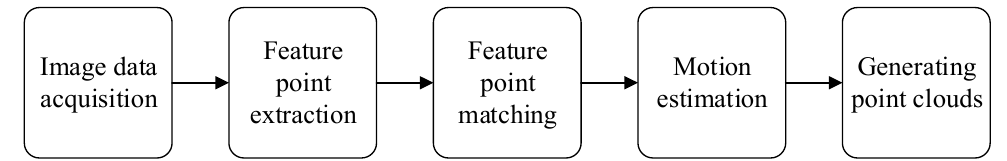
Figure 1. Three-dimensional (3D) reconstruction process of visual simultaneous localization and mapping (SLAM).